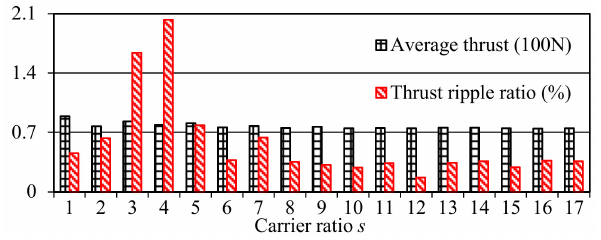
Figure 7. Thrust features versus the carrier ratio s for Array I.